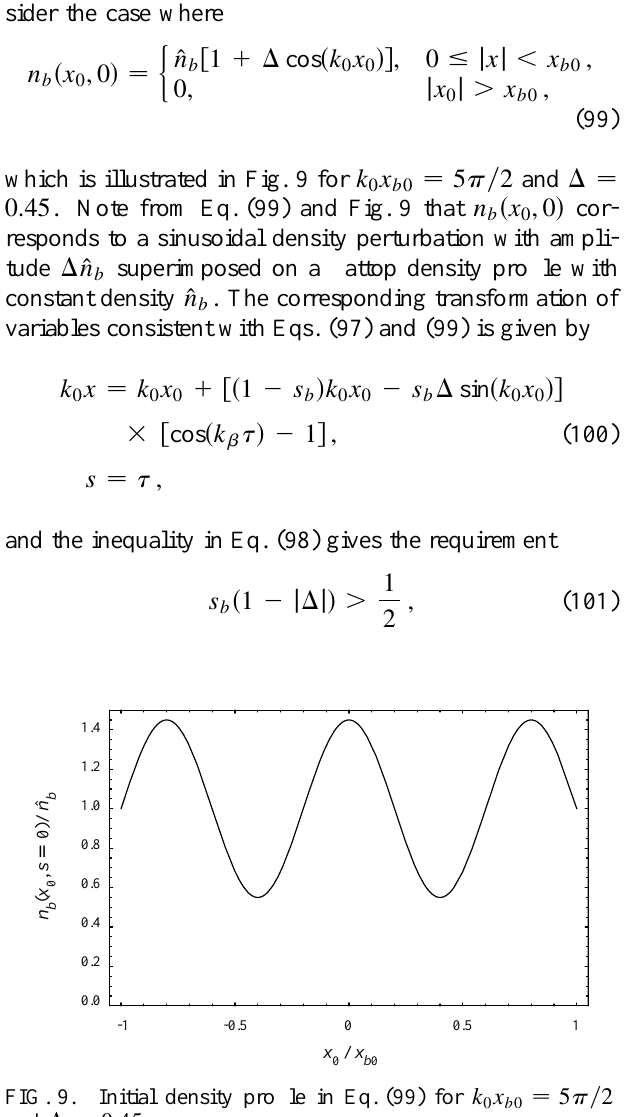
FIG. 9. Initial density profile in Eq. (99) for k 0 x b 0 (cid:1) 5 p (cid:3) 2 and D (cid:1) 0.45 .